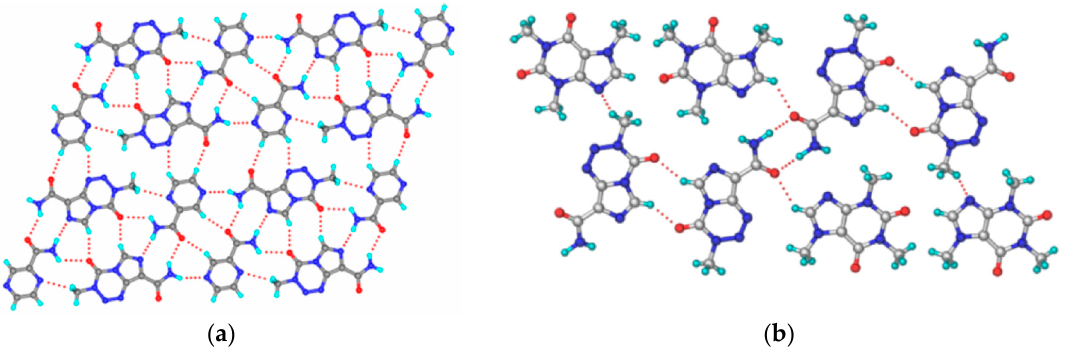
Figure 40. Hydrogen bond interaction present in 1:1 temozolomide cocrystal of ( a ) pyrazinamide and ( b ) caffeine. Adapted with permission from Crystal Growth & Design , 2013, 13 (5), 2208–2219. Copyright 2013, American Chemical Society.